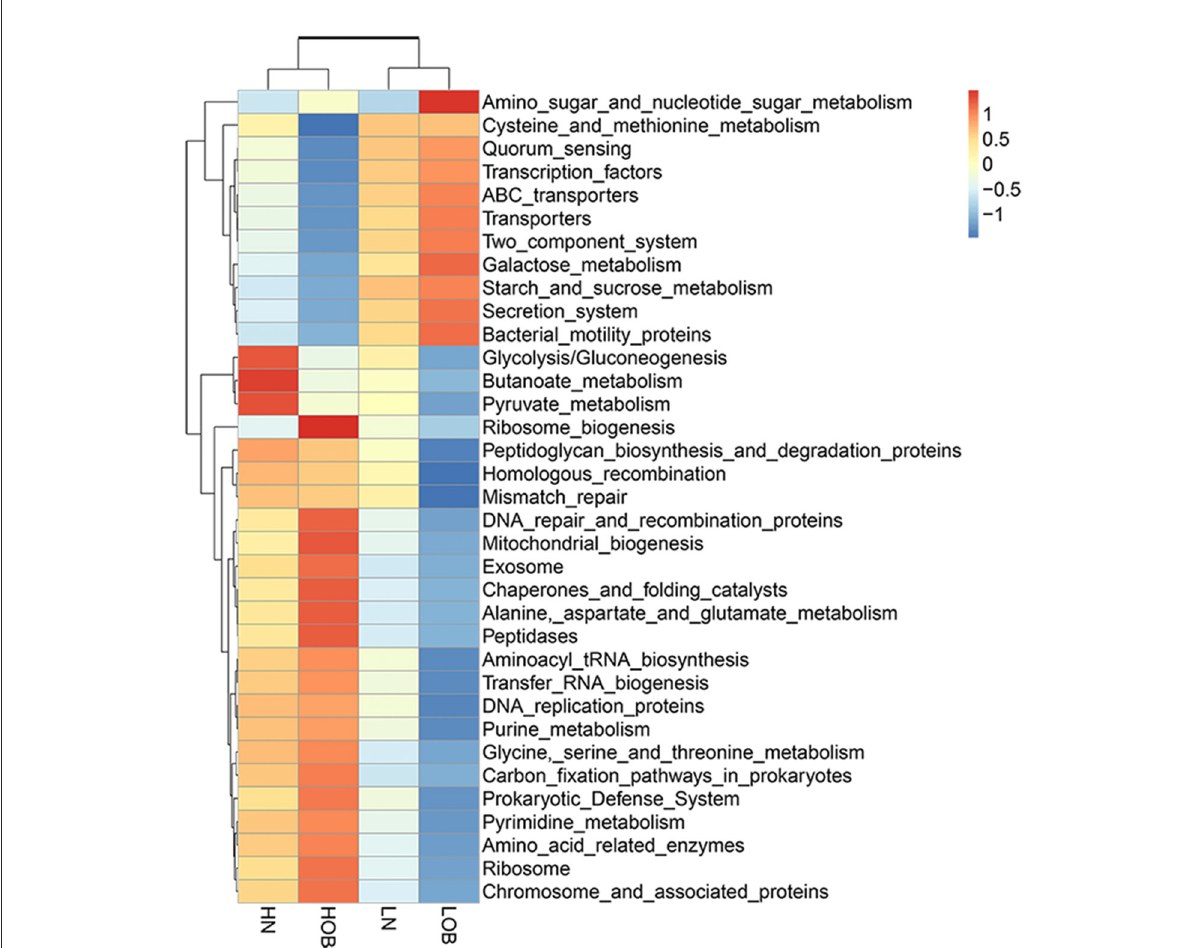
FIGURE7 Functional profiles of the fecal microbial communities in four groups. The 35 most-abundant pathways at the third level of KEGG pathways are shown in the heatmap. LN, low-altitude normal weight children; LOB, low-altitude obese children; HN, high-altitude normal weight children; HOB, high-altitude obese